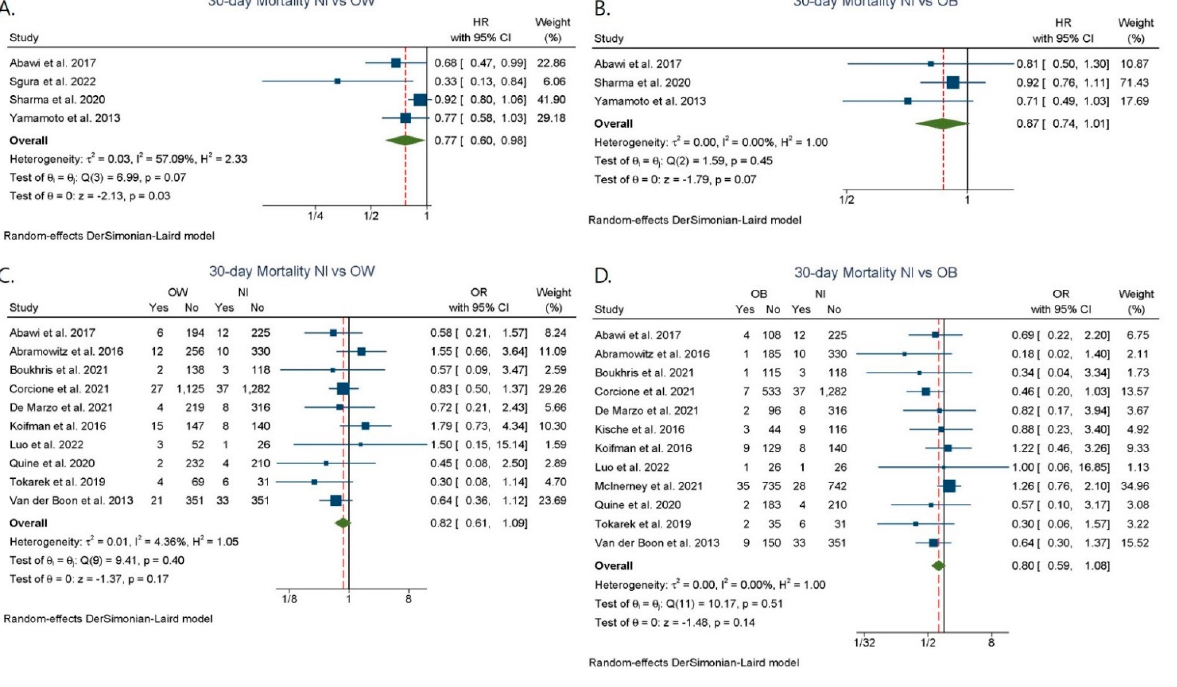
Figure 2. Short-term (30-day) mortality after TAVR among different BMI categories. ( A ) Normal BMI vs. Overweight. ( B ) Normal BMI vs. Obesity. ( C ), Normal BMI vs. Overweight. ( D ) Normal BMI vs. Obesity. HR: hazard ratio; Nl: normal BMI; OW: overweight; OB: obesity; OR: odds ratio [7,9,10,12,23,24,26,30,31,34,37,40–43].